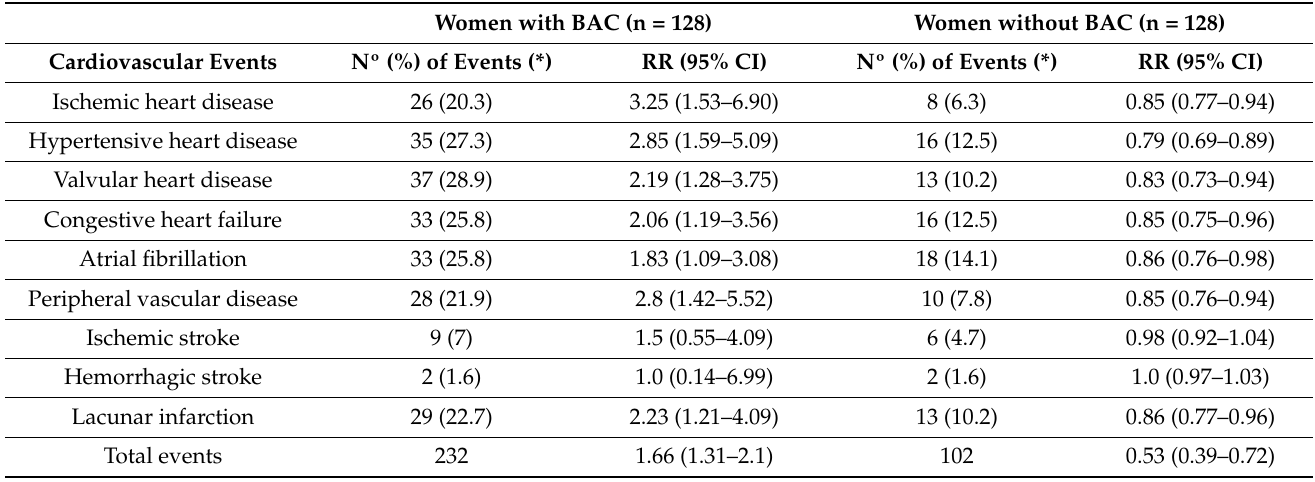
Table 2. Relative risk of the occurrence of cardiovascular events during the follow-up period in women with or without BAC.